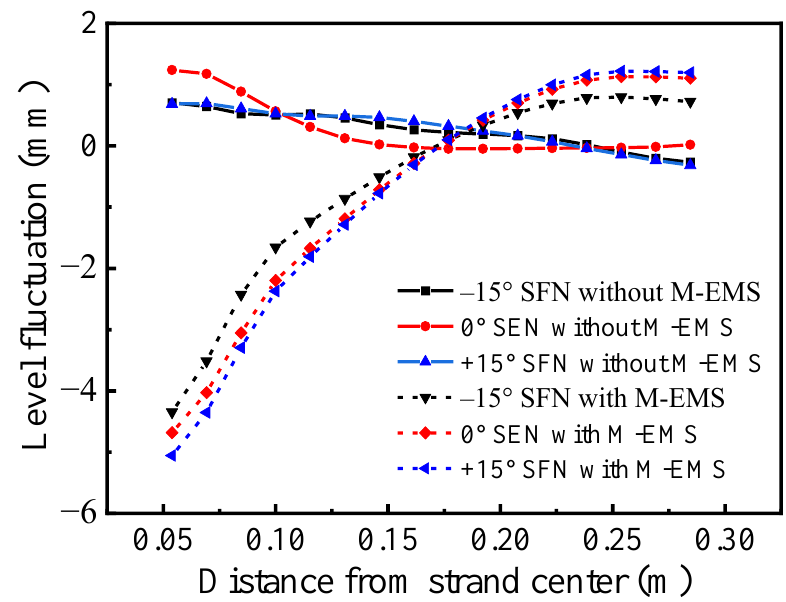
Figure 16. Level fluctuations along the centerline of the meniscus. The tangential velocity distributions along the centerline of the meniscus as shown in Figure 17. When M-EMS is off, the maximum tangential velocities of − 15 ◦ SFN, 0 ◦ SEN, and +15 ◦ SFN are smaller, which are 0.011 m/s, 0.018 m/s, and 0.011 m/s, respectively. The tangential velocity of ± 15 ◦ SFN fluctuates on the meniscus, which represents the vortex phenomenon of molten steel in the meniscus. When M-EMS is turned on, the maximum tangential velocities of − 15 ◦ SFN, 0 ◦ SEN, and +15 ◦ SFN are significantly increased, which are 0.125 m/s, 0.136 m/s, and 0.150 m/s, respectively. When the meniscus velocity is too high, the periodic level fluctuation in the mold will cause exposure to the molten steel surface, resulting in the secondary oxidation of molten steel and slag entrapment. The − 15 ◦ SFN should be selected if M-EMS is used. It should be avoided to use +15 ◦ SFN and M-EMS at the same